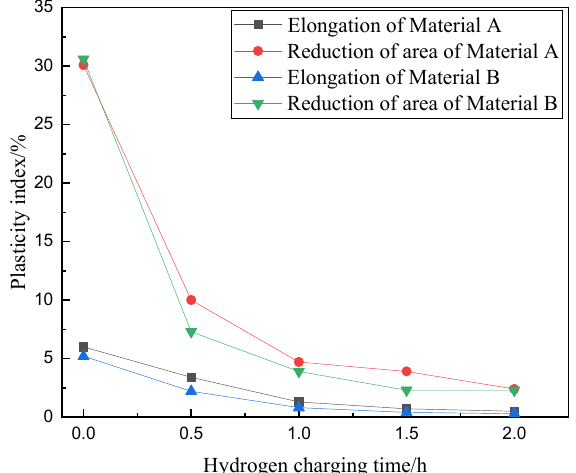
Figure 3. Plasticity index curve at different hydrogen charging times.